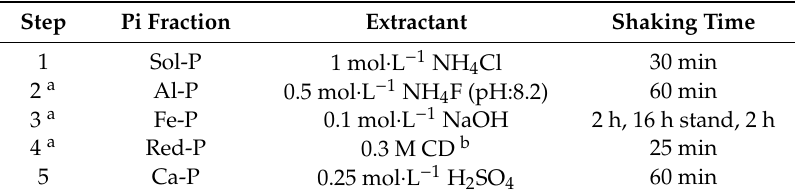
Table 2. Sequential Pi fractions based on the